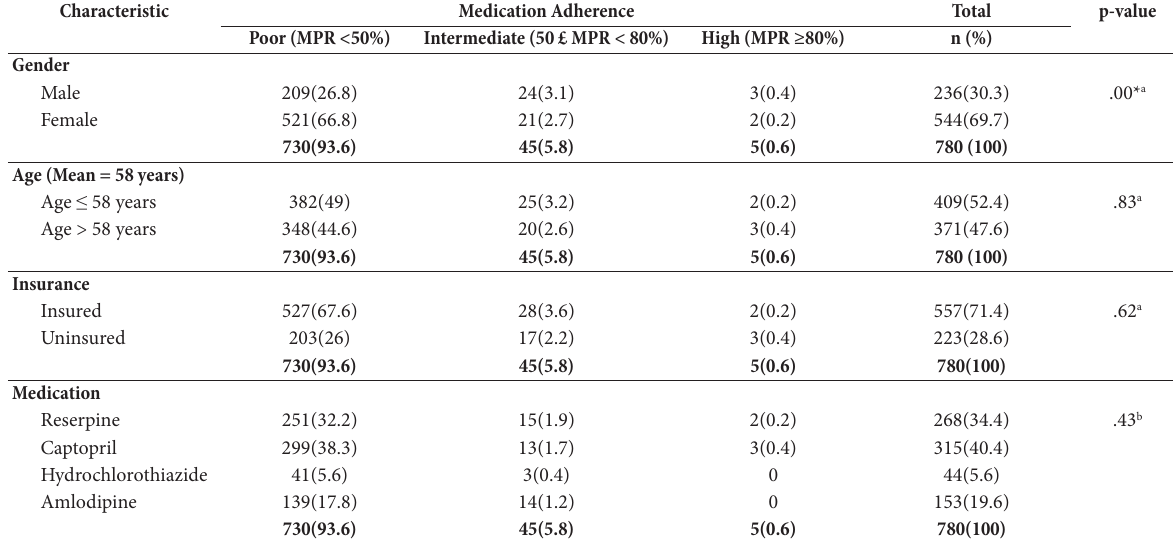
Table 2. Medication adherence.